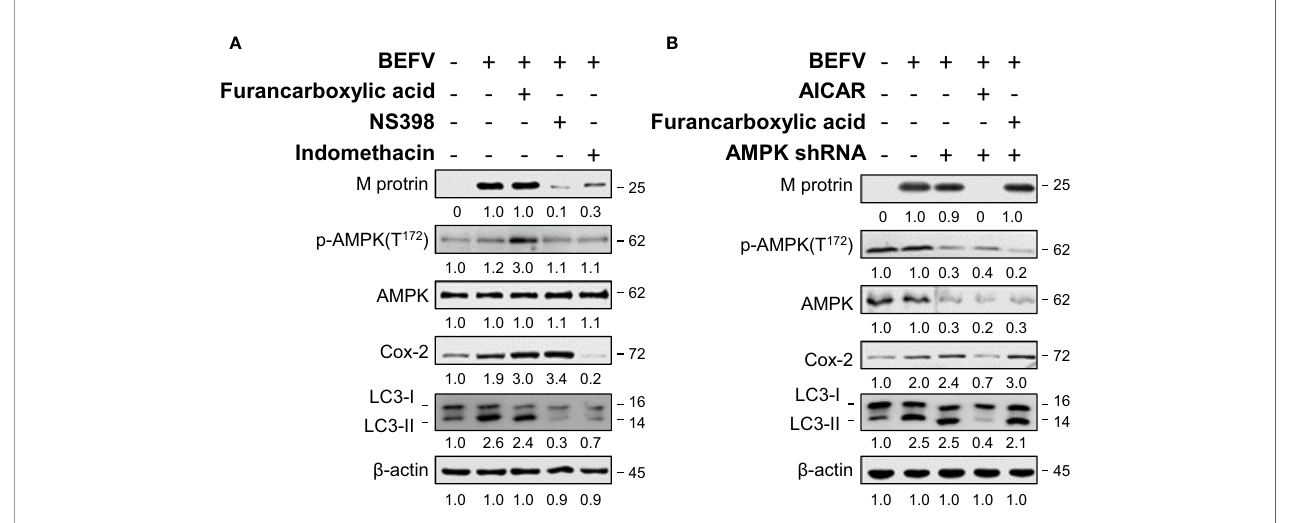
FIGURE 2 | BEFV-induced autophagy requires Cox-2 and is AMPK-independent. (A) MDBK cells were pretreated either with Furancarboxylic acid, NS-398 (25 m M) and indomethacin for 1 h followed by infection with BEFV at an MOI of 1 for 18 h. (B) MDBK cells were transfected with AMPK shRNA for 6 h, then with or without pretreatment of Furancarboxylic acid or AICAR for 1 h, followed by infection with BEFV at an MOI of 1. The cell lysates were harvested at 18 hpi and subjected to immunoblotting using antibodies as indicated. The levels of indicated proteins in the mock group were considered onefold. The activation and inactivation folds indicated below each lane were normalized against values for the mock control group. Protein levels were normalized to those for b ‐ actin. Signals in all Western blots were quanti fi ed with ImageJ software. All experiments were conducted in three independent experiments. The predicted size of each protein was labeled at the right- hand side in